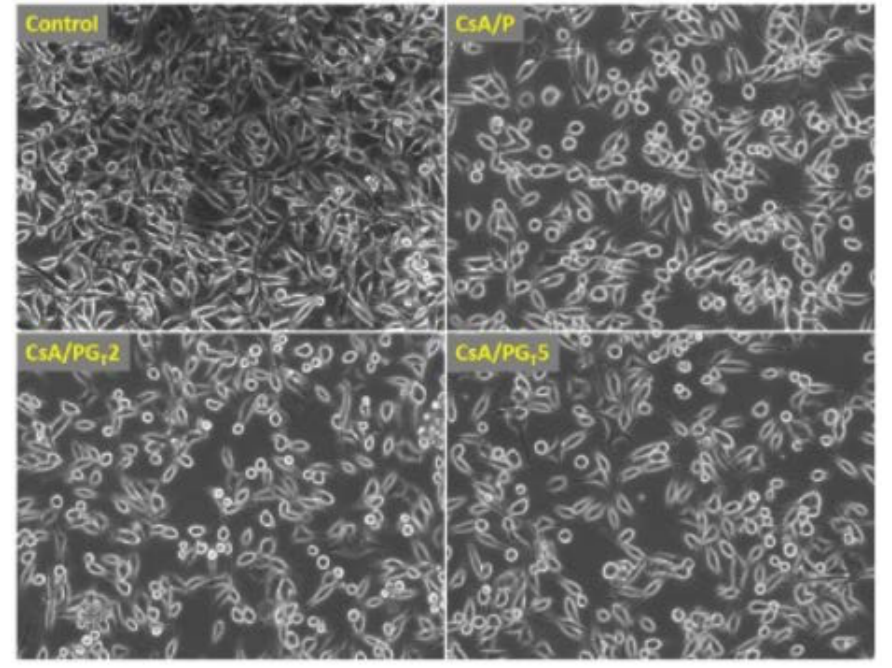
Figure 12. Microscopic images of fibroblasts on fibrous materials, reprinted from [10 4]